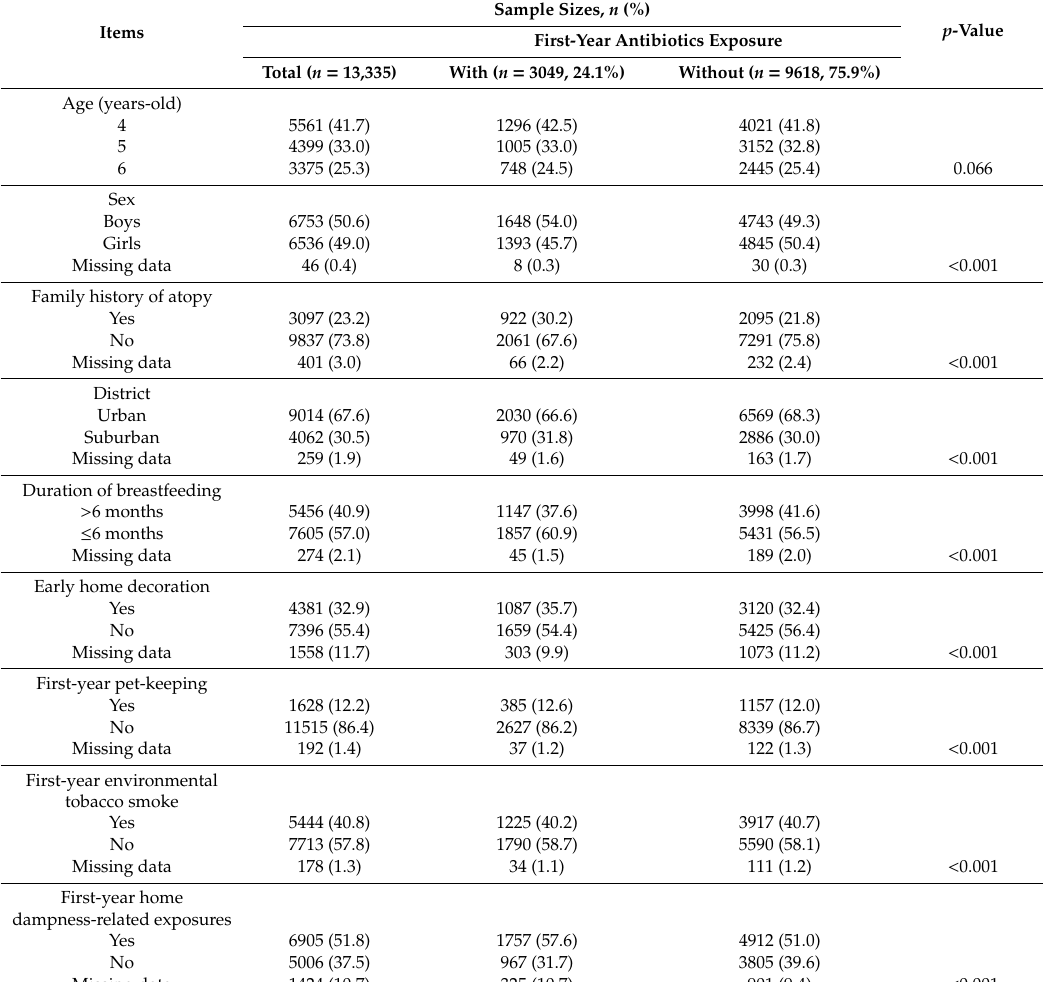
Table 1. Demographic characteristics and covariates ( n =